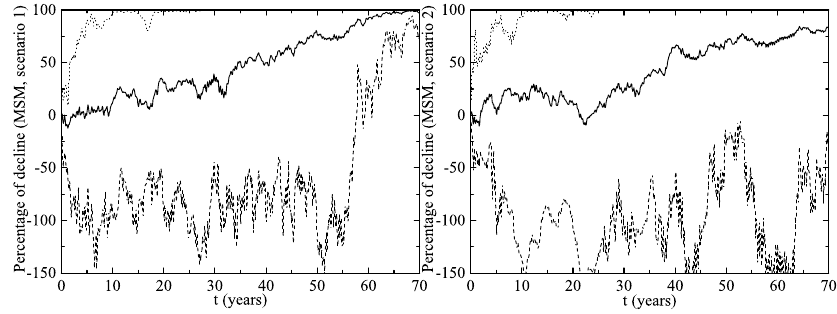
Figure 6. Herd immunity effect of the vaccination program in Australia on heterosexual men ( left figure (Scenario 1) and right figure (Scenario 2)). The upper dotted and the lower dashed lines correspond to an interval of 90% confidence. The solid line is the average evolution of the decline in GW.